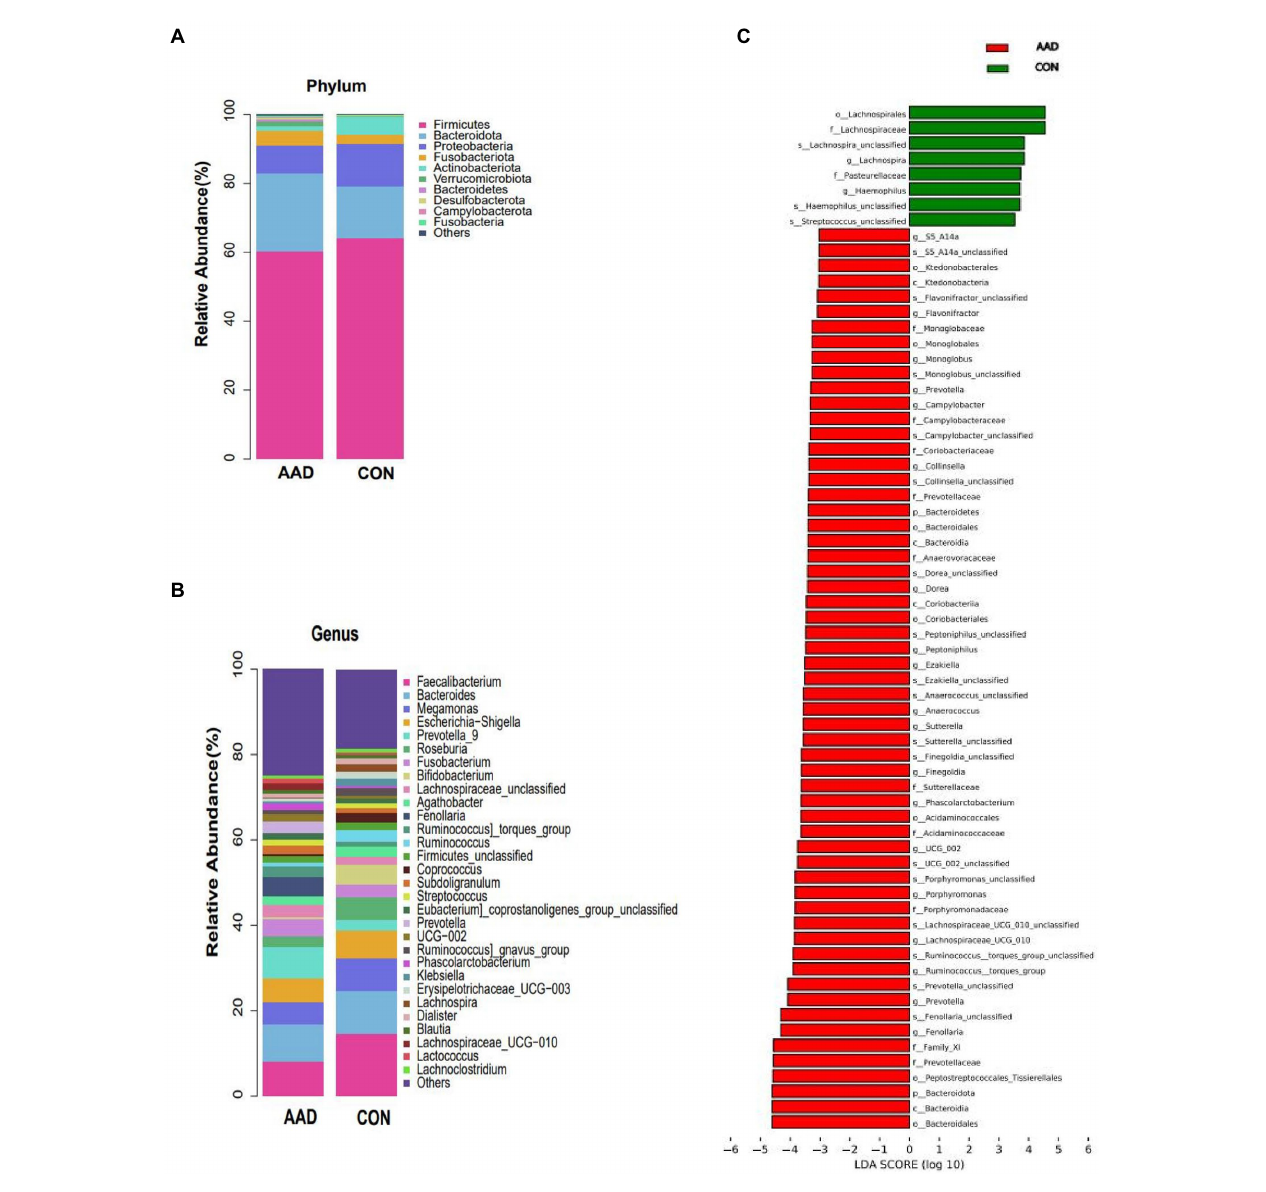
FIGURE 2 Taxa differences between patients with AAD and healthy controls. Relative abundance of the major bacteria at the (A) phylum and (B) genus levels. (C) Differences in intestinal bacteria between the AAD and control groups. LefSe (LDA score > 3) was used to detect major differences in bacterial taxa between patients with AAD and healthy controls. Red bars are genera with higher relative abundance in patients with AAD. Green bars are genera with higher relative abundance in healthy controls. X -axis shows the log LDA scores; LDA, linear discriminant analysis; N =